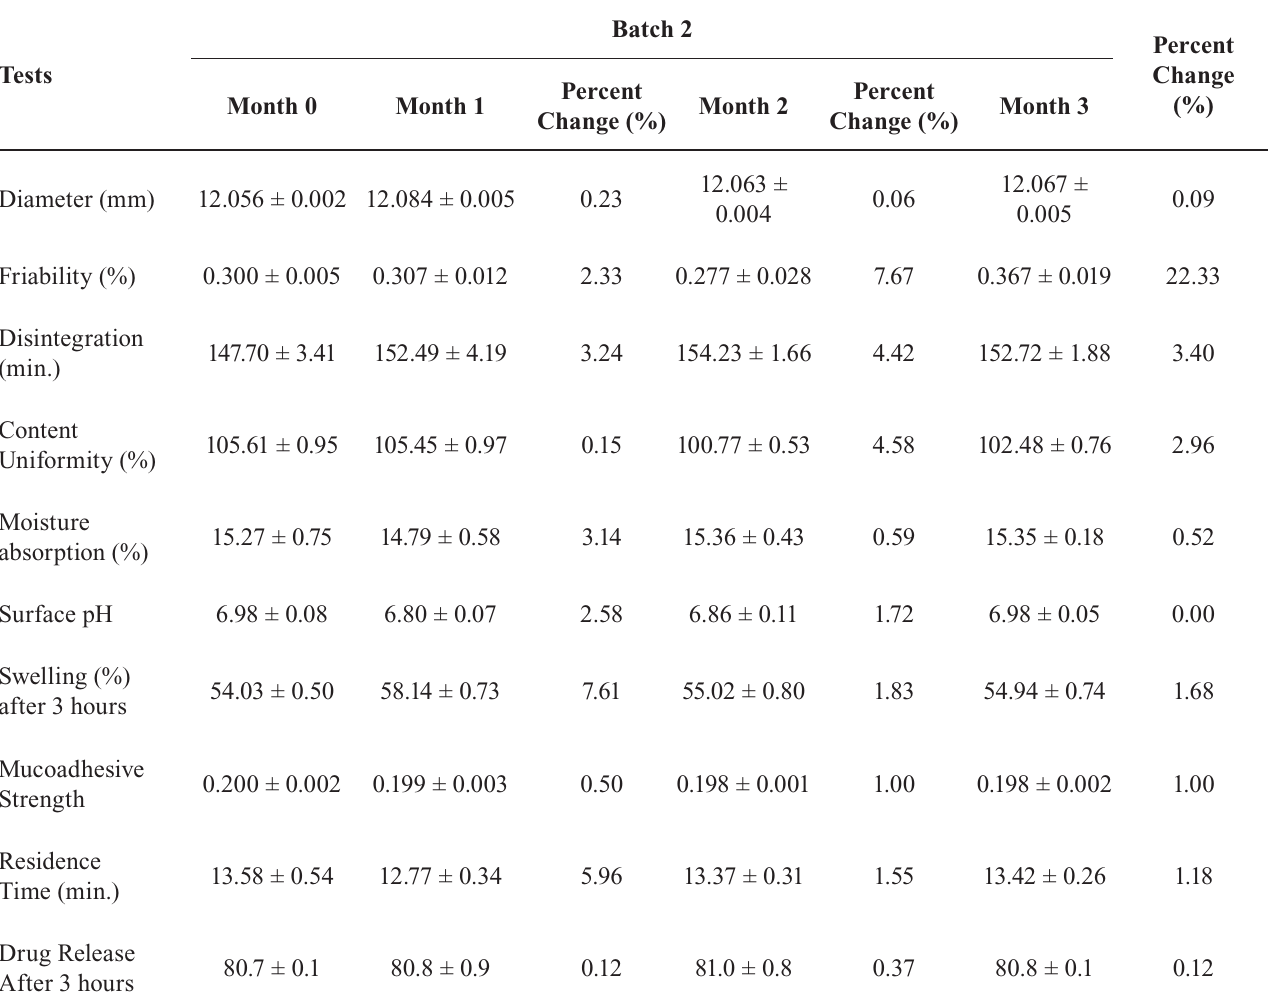
TABLE VI - Summary of the results for Batch 2: formulated mucoadhesive mefenamic acid buccal